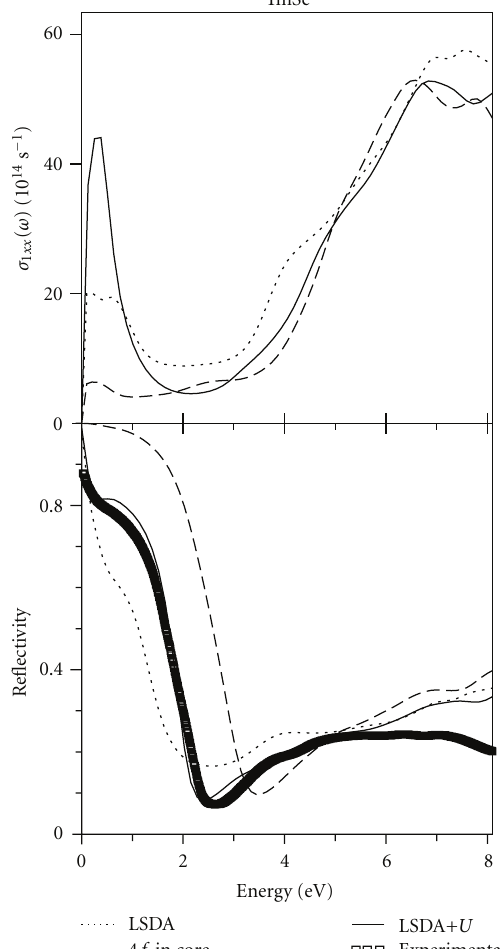
Figure 73: Calculated diagonal part of the optical conductivity σ 1 xx and the optical reflectivity R of TmSe treating the 4 f states as (1) fully localized (4 f in core) (dashed line), (2) itinerant (LSDA) (dotted line), and (3) partly localized (LSDA+ U ) (solid line) [384] compared with the experimental data [389] (open squares).